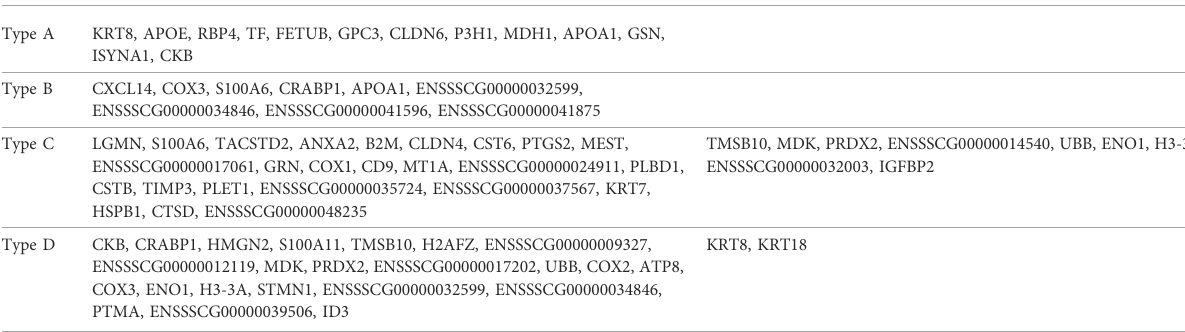
TABLE 5 List of type-speci fi c up- or down-regulated genes from the four cell types. Sample Upregulated